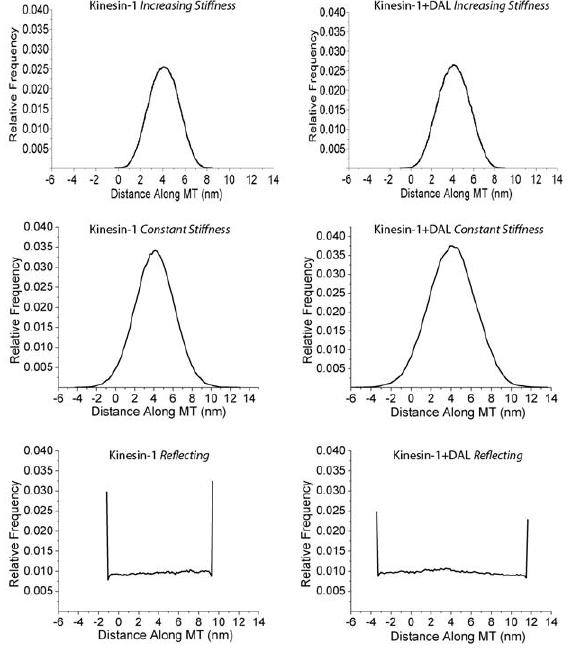
Figure 4. Stationary Distributions for All Models. Stationary distributions for the Increasing Stiffness , Constant Stiffness , and Reflecting models of the neck linker domain. The position of the free head of Kinesin-1 and Kinesin-1 + DAL was simulated by setting k attach to zero. A 4 nm bias resulting from ATP binding and neck linker docking is assumed in all